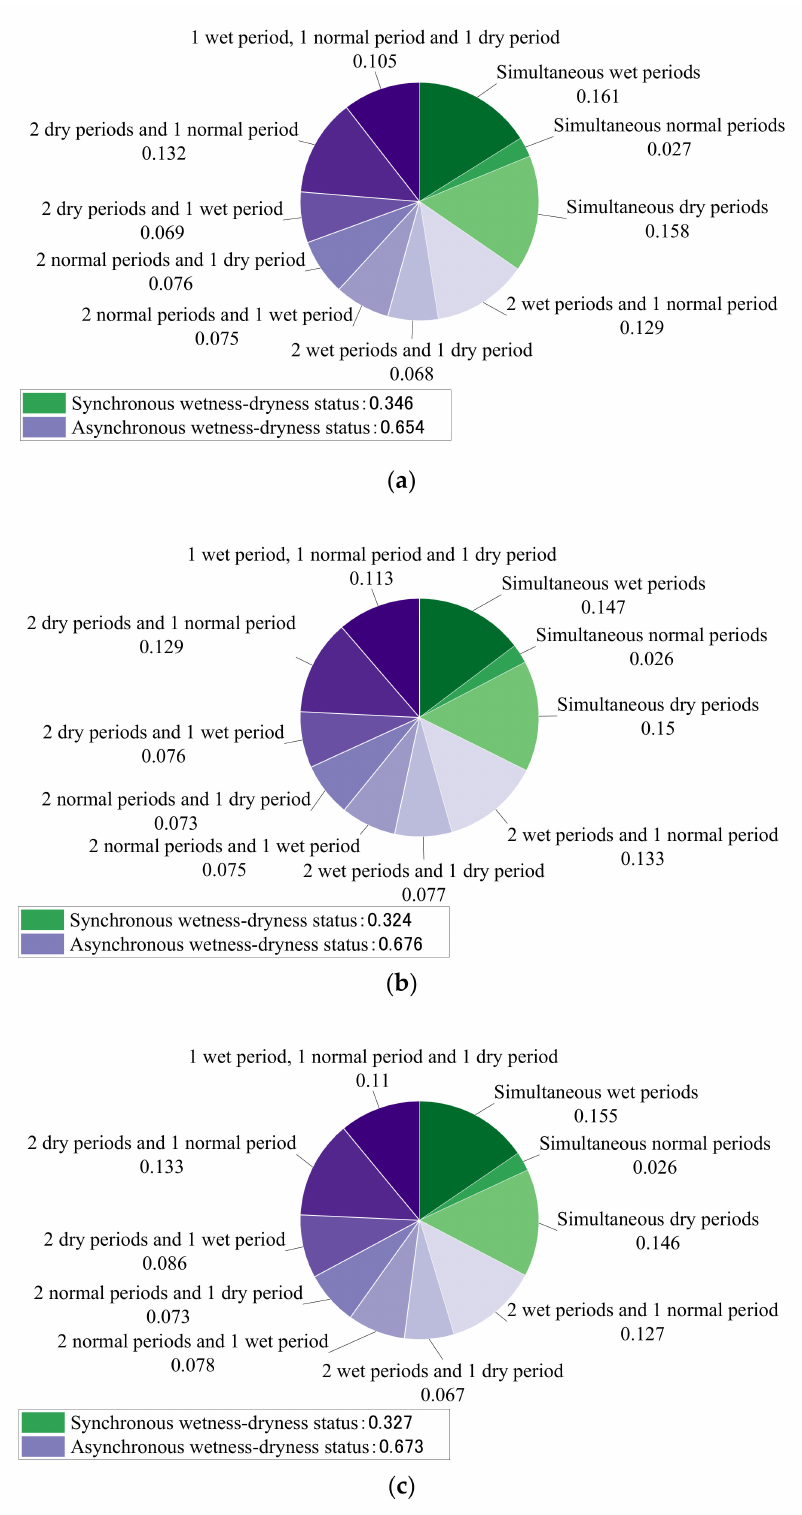
Figure 9. The 10 kinds of combinations and their calculated values of frequencies at three scales: ( a ) is under the annual scale; ( b ) is in flood season; and ( c ) is in non-flood season. As shown in Figures 8 and 9, the statistical laws of the wetness-dryness combinations at the three scales are basically the same. The frequencies of synchronous wetness-dryness status are all between 0.32 and 0.35, and the frequencies of asynchronous